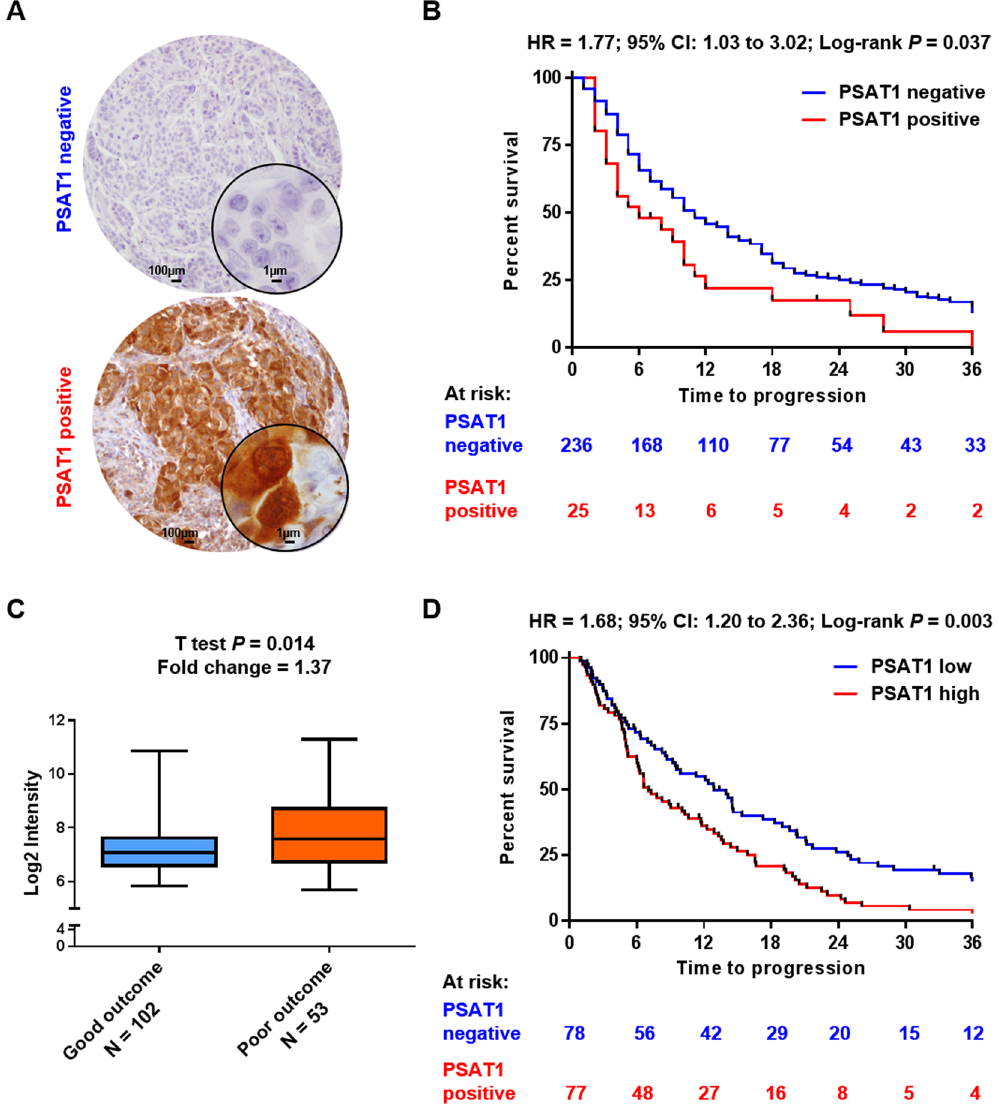
Figure 2. PSAT1 expression and clinical relevance in the TMA and Affymetrix datasets. Breast carcinoma IHC stained tissues either displayed high or low PSAT1 protein levels. Two representative specimen having either high or low PSAT1 are presented (panel A). Kaplan-Meier analysis showed that high expression of PSAT1 protein was significantly associated to shorter TTP when compared to tumors with low PSAT1 levels (panel B). PSAT1 mRNA levels were assessed by Affymetrix GeneChip. Statistical analysis not only showed PSAT1 mRNA expression was enrihed in poor outcome patients (t test P = 0.014; panel C), but Kaplan Meier analysis showed that, also in this set, PSAT1 expression was significantly associated to shorter TTP (panel